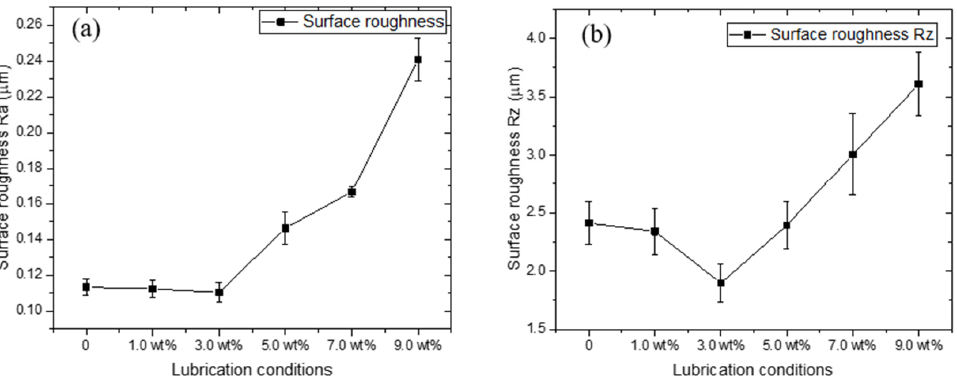
Figure 3. The surface roughness of the rolled copper foils under different lubrication conditions (50% reduction): ( a ) Ra and ( b ) Rz.